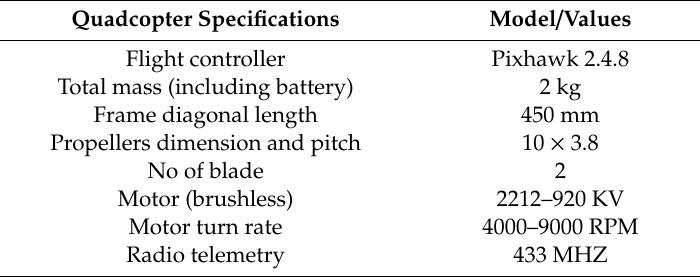
Table 1. Specifications of the F450 spider quadcopter.